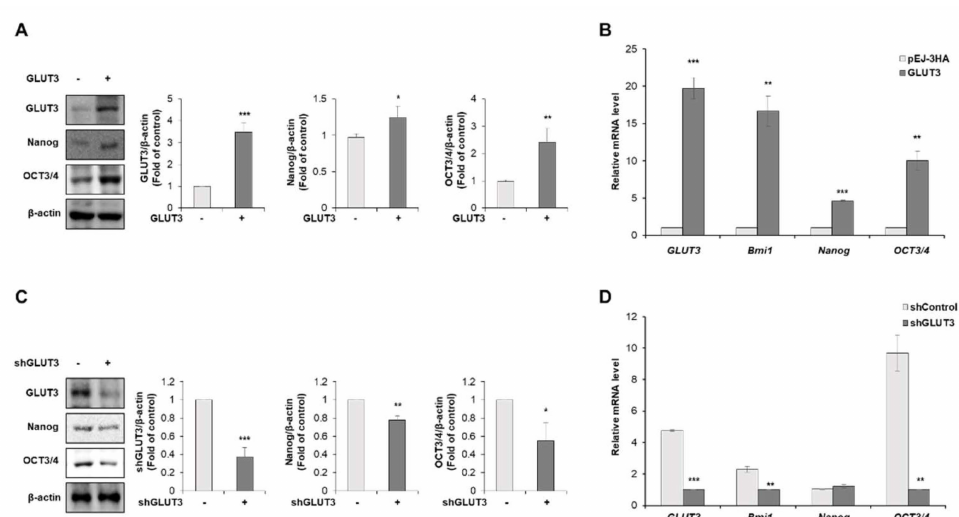
Figure 3. Overexpression and knockdown of GLUT3 regulates stemness markers in CRC cells. ( A ) HCT116 cells were transfected with GLUT3/pEJ-3HA (2 µ g) for 24 h. Western blot analysis was conducted for measuring the protein levels of GLUT3, Nanog and OCT3/4. ( B ) qRT-PCR was conducted to measure the mRNA levels of GLUT3, Bmi1, Nanog and OCT3/4. ( C ) Western blot analysis was conducted for measuring the protein levels of GLUT3, Nanog and OCT3/4 in shGLUT3- transfected SW620 cells. ( D ) qRT-PCR was conducted to measure the mRNA levels of GLUT3, Bmi1, Nanog and OCT3/4 in shGLUT3-transfected SW620 cells. GLUT3, glucose transporter 3; CRC, colorectal cancer; qRT-PCR, quantitative reverse transcription PCR. Data are the mean ± standard deviation. Statistical significance was analyzed by analysis of variance. * p < 0.05, ** p < 0.01 and *** p < 0.001, significantly different compared with